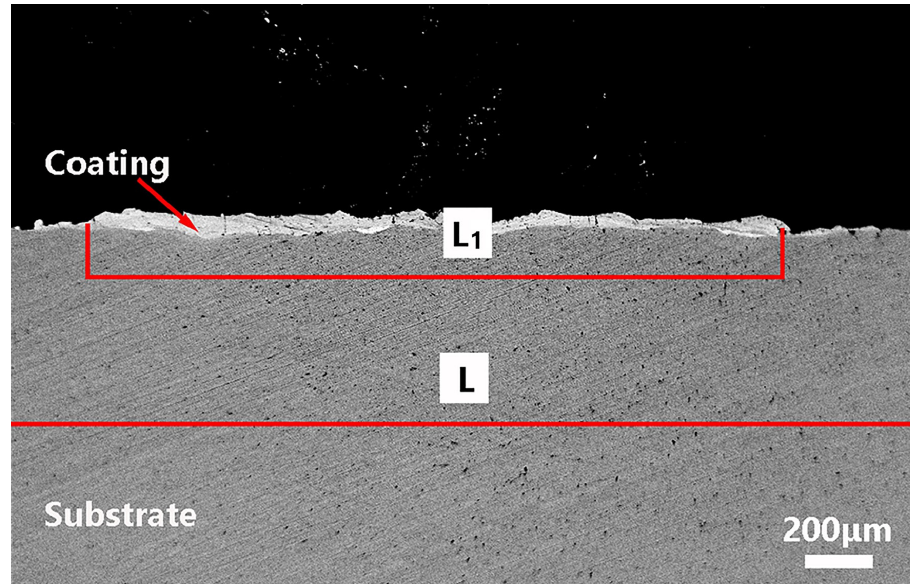
Figure 2. Schematic diagram of coverage calculation.